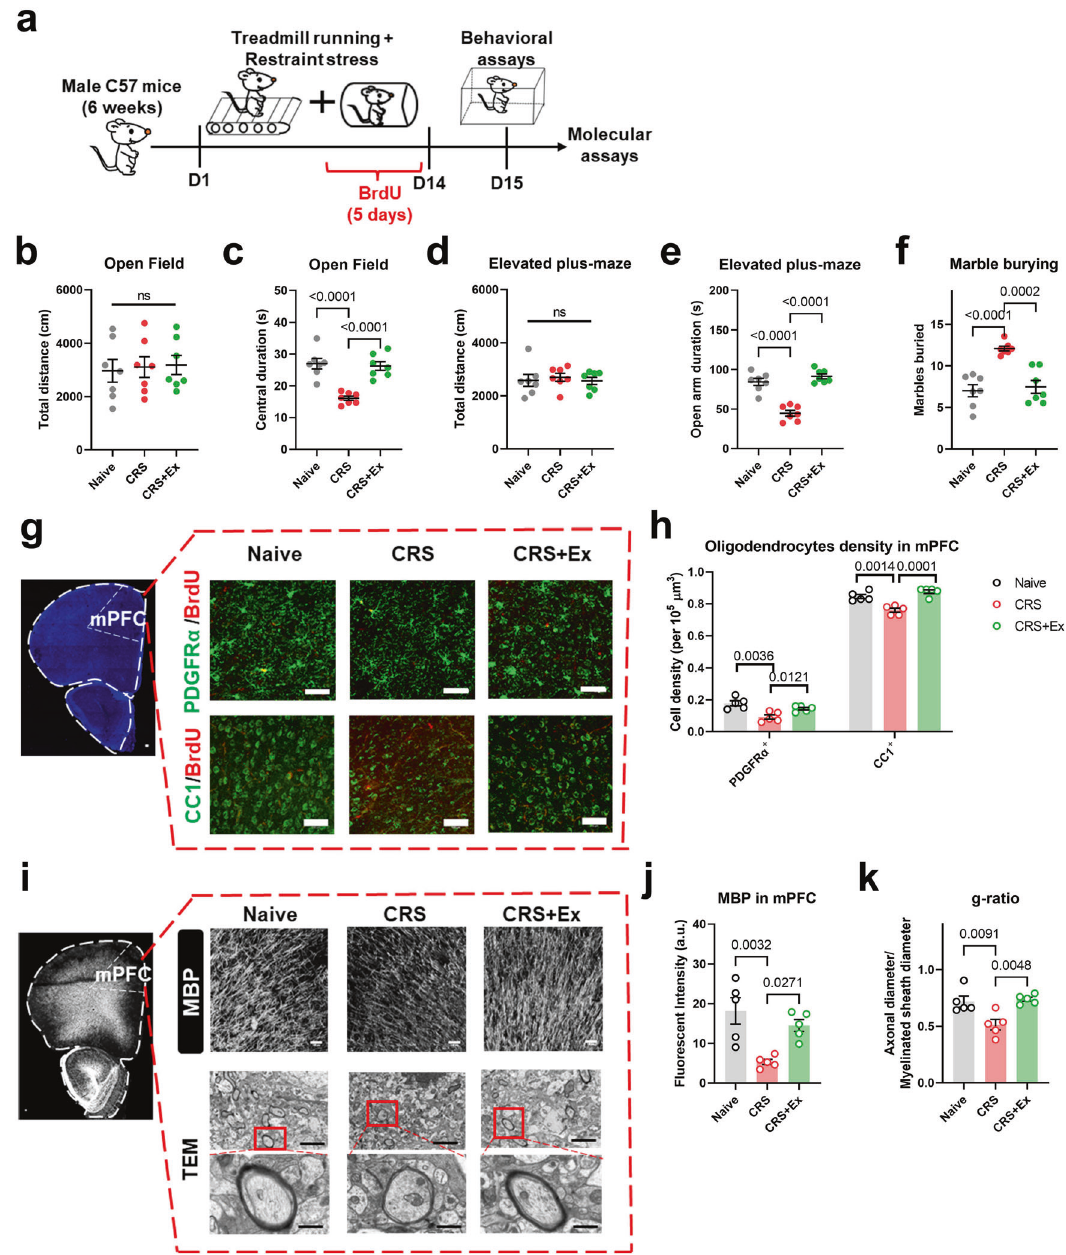
Fig. 1 Physical exercise prevents chronic stress-induced anxiety-like behaviors and axonal demyelination. a Schematic illustration of experimental designs. b Total distance traveled in the open fi eld was unaffected by chronic restrain stress (CRS) or exercised (Ex). One-way ANOVA, F (2,18) = 0.07908, P = 0.9243. c Time spent in the central region in the open fi eld was decreased by CRS and was elevated in the Ex group. One-way ANOVA, F (2,18) = 21.95, P < 0.0001. d Total movement distance on the elevated plus maze was unchanged across groups. One-way ANOVA, F (2,18) = 0.1719, P = 0.8434. e Time duration in the open arm on the elevated plus maze was decreased by CRS and was maintained in CRS + Ex group. One-way ANOVA, F (2,18) = 44.95, P < 0.0001. f The number of marbles buried was increased by CRS and was suppressed in CRS + Ex group. One-way ANOVA, F (2,18) = 19.63, P < 0.0001. N = 7 mice in each group in ( b – f ). Tukey ’ s post-hoc test was used for comparisons between the two groups. g Fluorescent images showing the co-labeling of oligodendrocyte marker (PDGFR α or CC1) with BrdU. Scale bar, 100 μ m. h The density of PDGFR α or CC1 cells was decreased by CRS and was maintained in CRS + Ex group. Multiple t -test was used for comparisons between the two groups. i Upper panels, fl uorescent images of MBP in mPFC region. Middle and lower panels, transmission electron microscopy (TEM) images of axonal fi bers, with high-magni fi cation images showing the morphology of individual myelin sheath (dark shade). Scale bar, 100 μ m in upper panels, 2 μ m in middle panels, and 500 nm in lower panels. j Fluorescent intensity (in arbitrary unit, or a.u.) of MBP was decreased by CRS and was maintained in CRS + Ex group. One-way ANOVA, F (2,12) = 9.436, P = 0.0034. k The g-ratio (de fi ned as the diameter of unmyelinated axonal fi bers divided by the diameter of the myelinated sheath) was decreased by CRS and was maintained in CRS + Ex group. One-way ANOVA, F (2,12) = 9.691, P = 0.0031. N = 5 mice in each group in ( g – k ). Tukey ’ s post-hoc test was used for comparisons between the two groups. All data were presented as mean ±